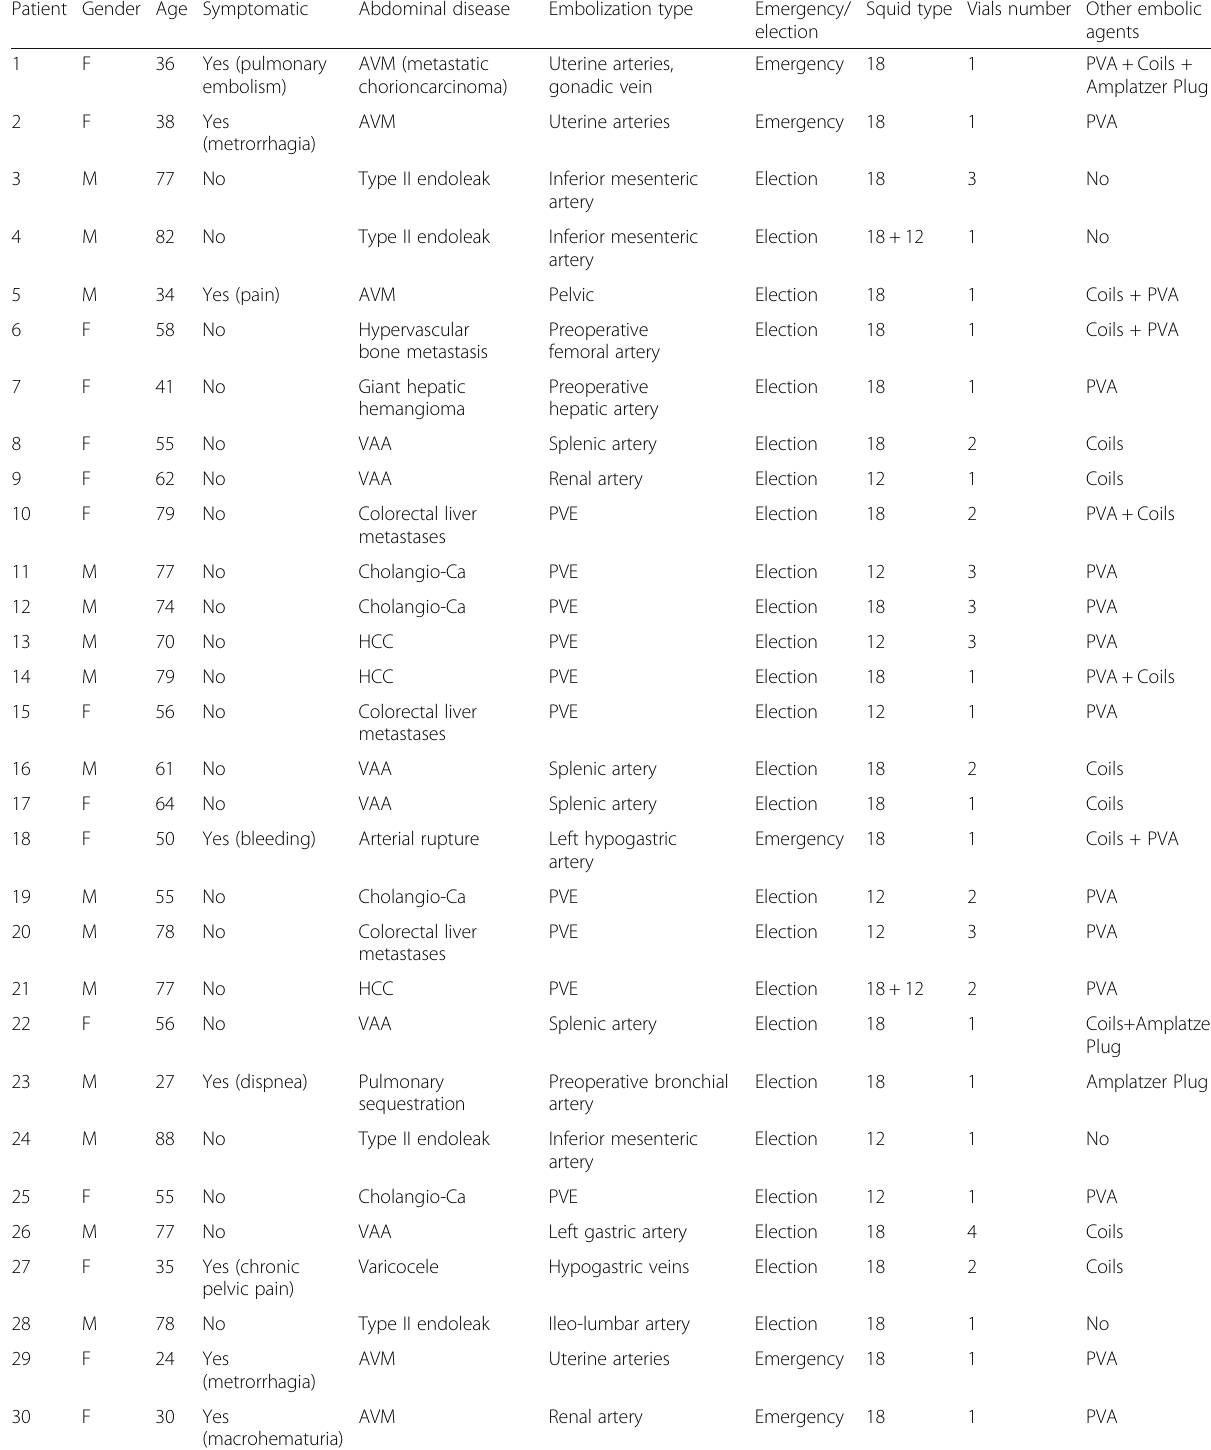
Table 1 Patients characteristics, abdominal disease, embolization type, Squid and other used embolic agents Patient Gender Age